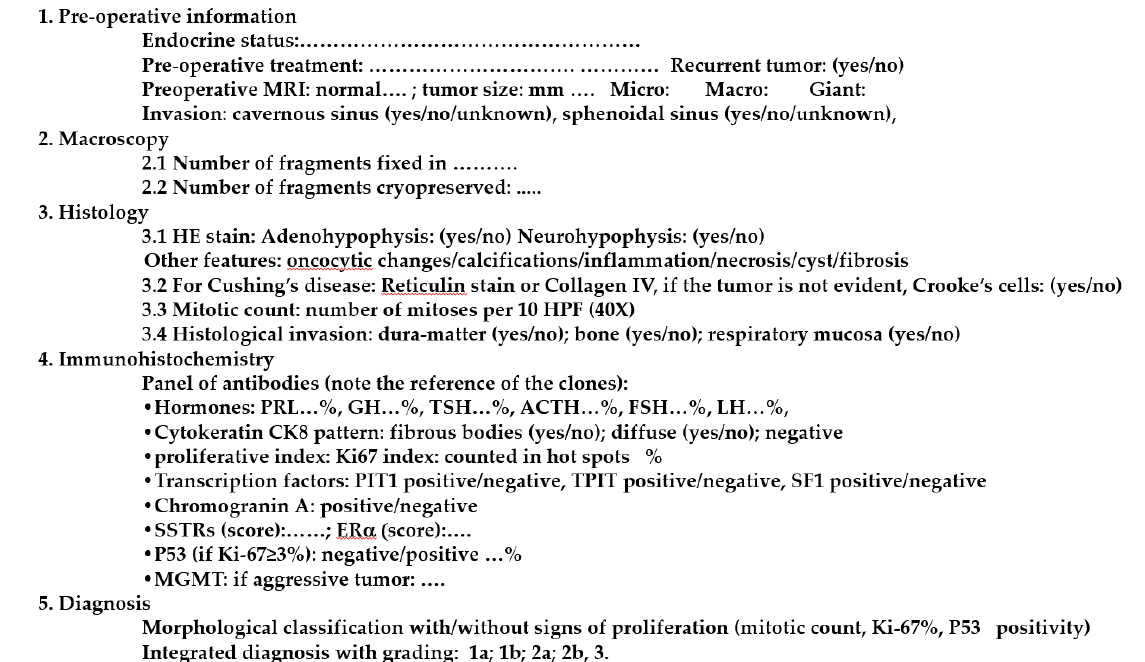
Figure 2. Standardized pathological report for PitNETs, adapted from EPPG